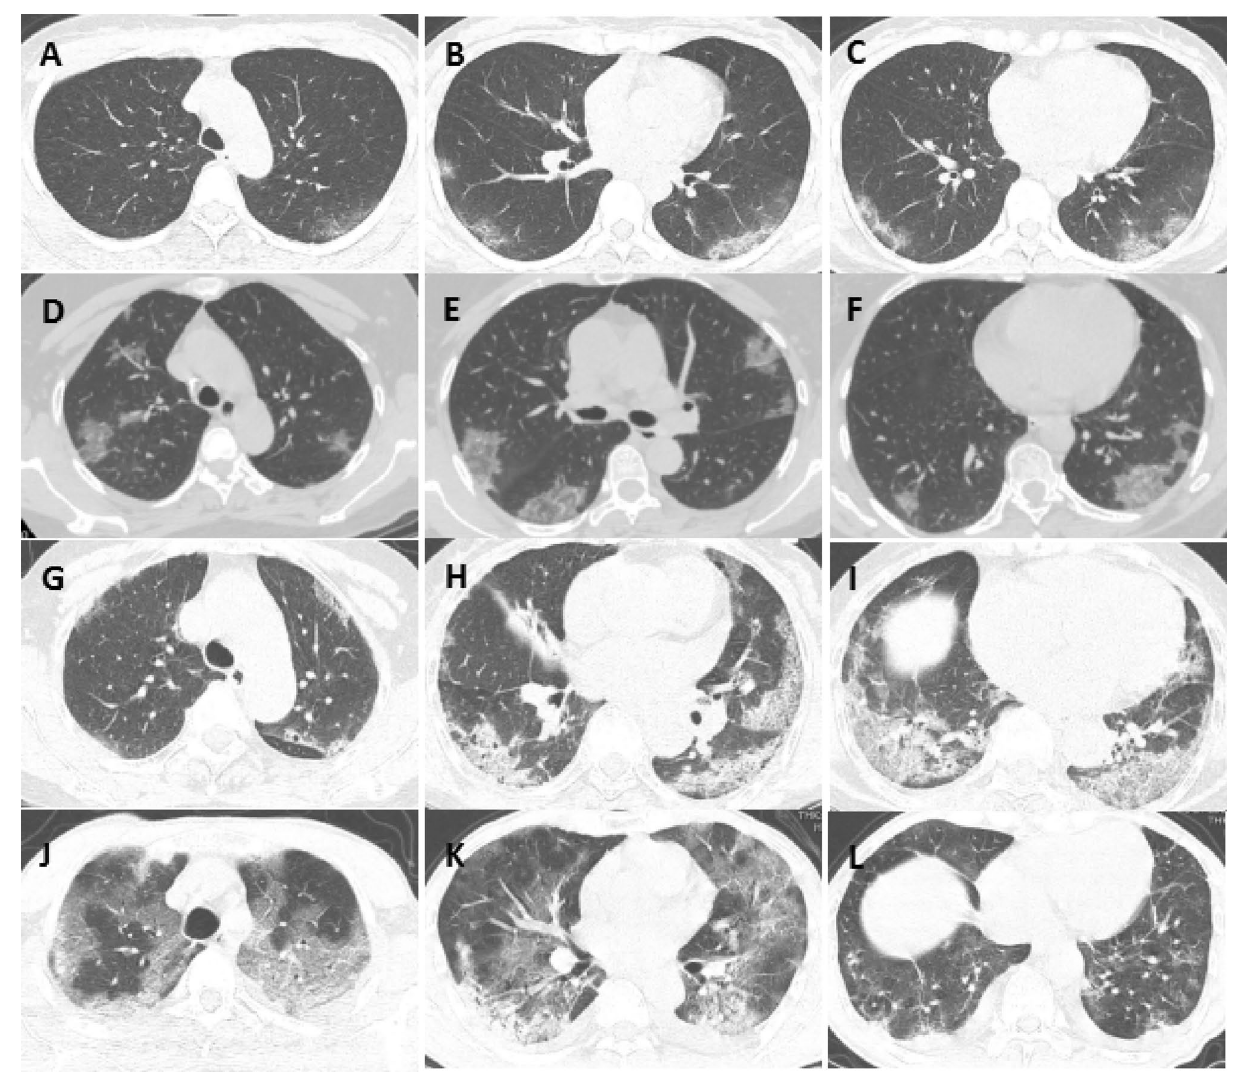
Figure 4. Grade and clinical classification of inflammatory factors. ( A – C ) 41-year-old female, ground glass opacities in both lungs, involving 5 lung segments, PII was 12.5%, inflammation grade I, clinically classified as moderate type; ( D – F ) 56-year-old female, scattered lung glass shadows, involving 13 lung segments, PII was 37.5%, degree of inflammation was grade II, clinically classified as moderate type; ( G – I ) 41-year-old female, double lung ground glass opacities with consolidation and thickened lobular septa, the image showed mixed type, involving 16 lung segments, PII is 62.5%, the degree of inflammation is grade III, clinically classified as severe type; ( J – L ) 57 years old, bilateral ground glass opacities combined with consolidation and stripe shadow, bilateral pleural effusion, involving 16 lung segments, PII is 77.5%, the degree of inflammation is grade IV, clinically classified as severe type. Imaging were acquired on GE AW VolumeShare software (Version number: 4.6; http:// www. gehea lthca re. com/ produ cts/ advan ced- visua lizat ion/ platf orms/ aw- server).